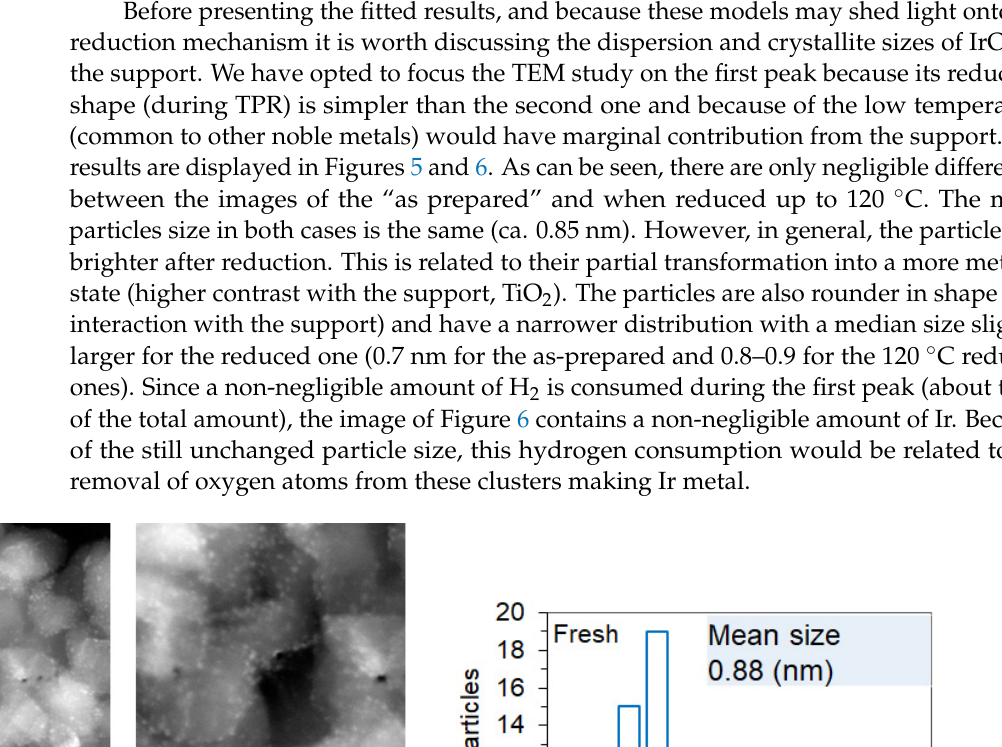
Figure 6. TEM images and extracted mean particle size of 3.5 wt.% IrO 2 /TiO 2 (anatase, BET surface area = 55 m 2 /g) that has been reduced during TPR up to 120 °C, at different magnifications. Standard errors (0.02 nm).